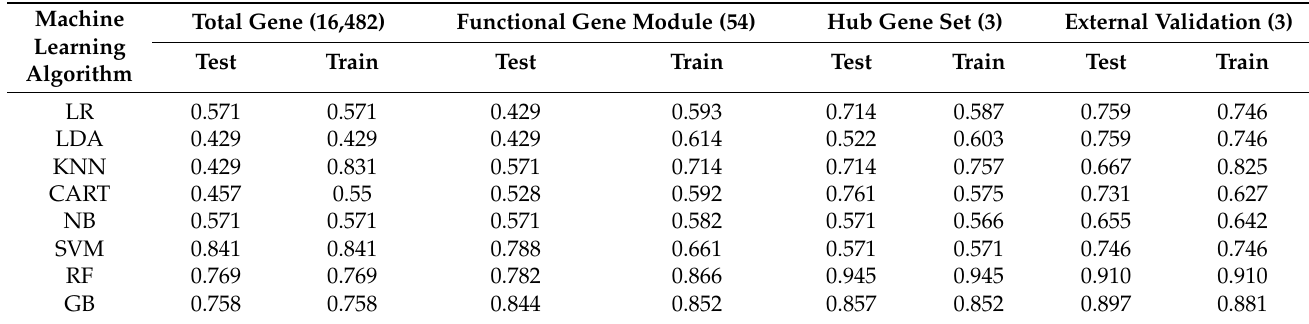
Table 2. RNA-sequencing data of accuracy of various machine learning techniques in breast cancer result. Test accuracy of each algorithm using total gene, functional gene module, and hub gene set